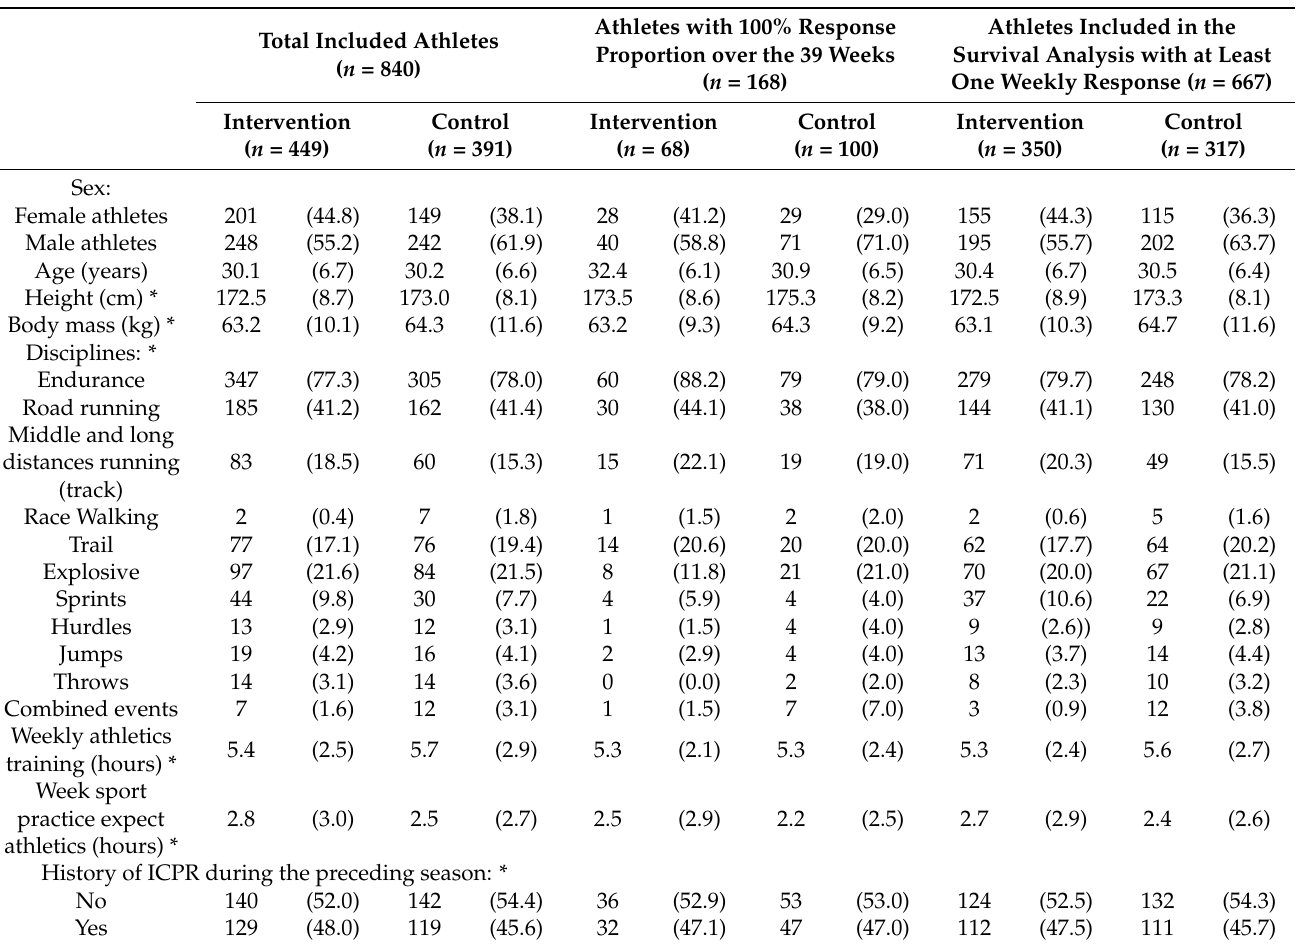
Table 2. Baseline characteristics at the individual level of the athletes included. Data are presented as mean and standard deviation (SD) for continuous variables, and numbers and percentages (%) for ordinal or categorical